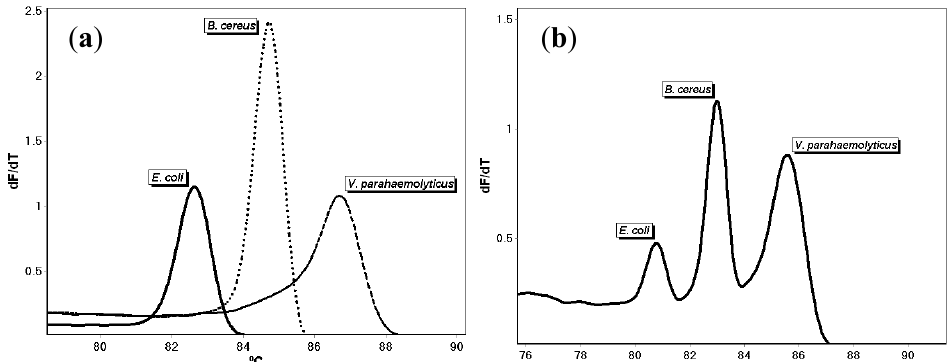
Figure 2. PCR melt curves for: ( a ) E. coli , B. cereus , and V. parahaemolyticus DNA tested individually using the triplex assay primer mix; ( b ) Melt curves of E. coli, B. cereus, and V. parahaemolyticus mixture tested together using the triplex assay.